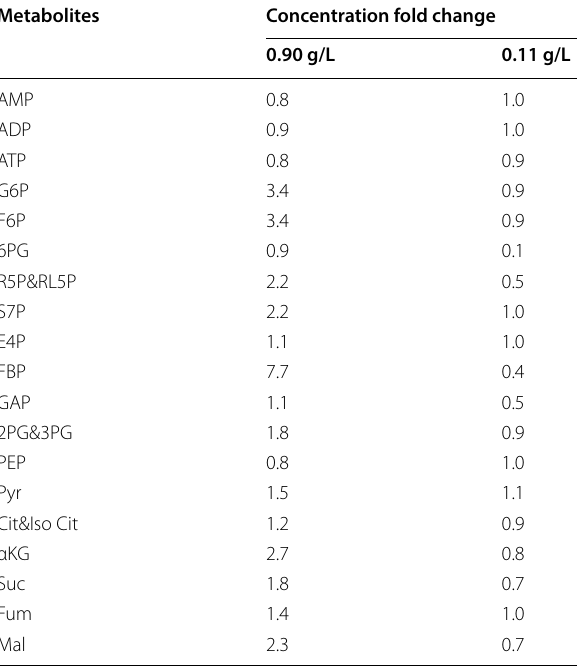
Fig. 6 Pathway turnover time in the central carbon metabolism after the glucose pulses. The bar chart shows the average turnover time for the first 10 min after the pulse of the EMP, PP, TCA pathway and the